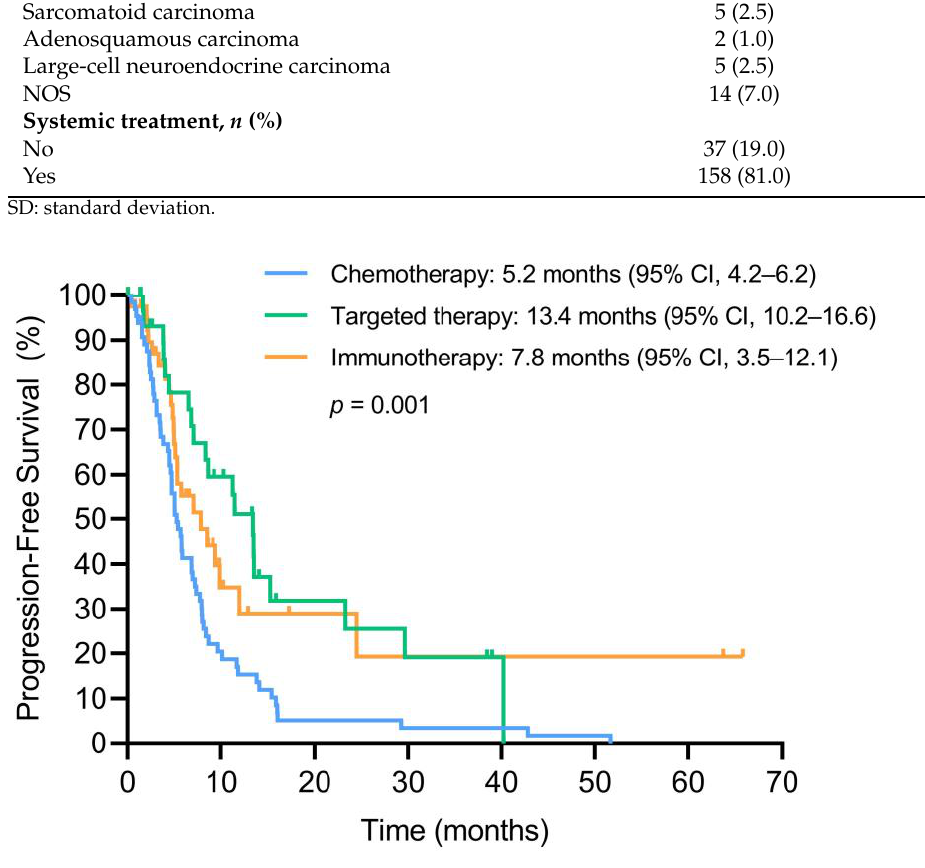
Figure 5. First-line progression-free survival of patients with stage IV NSCLC stratified by therapeutic approach.